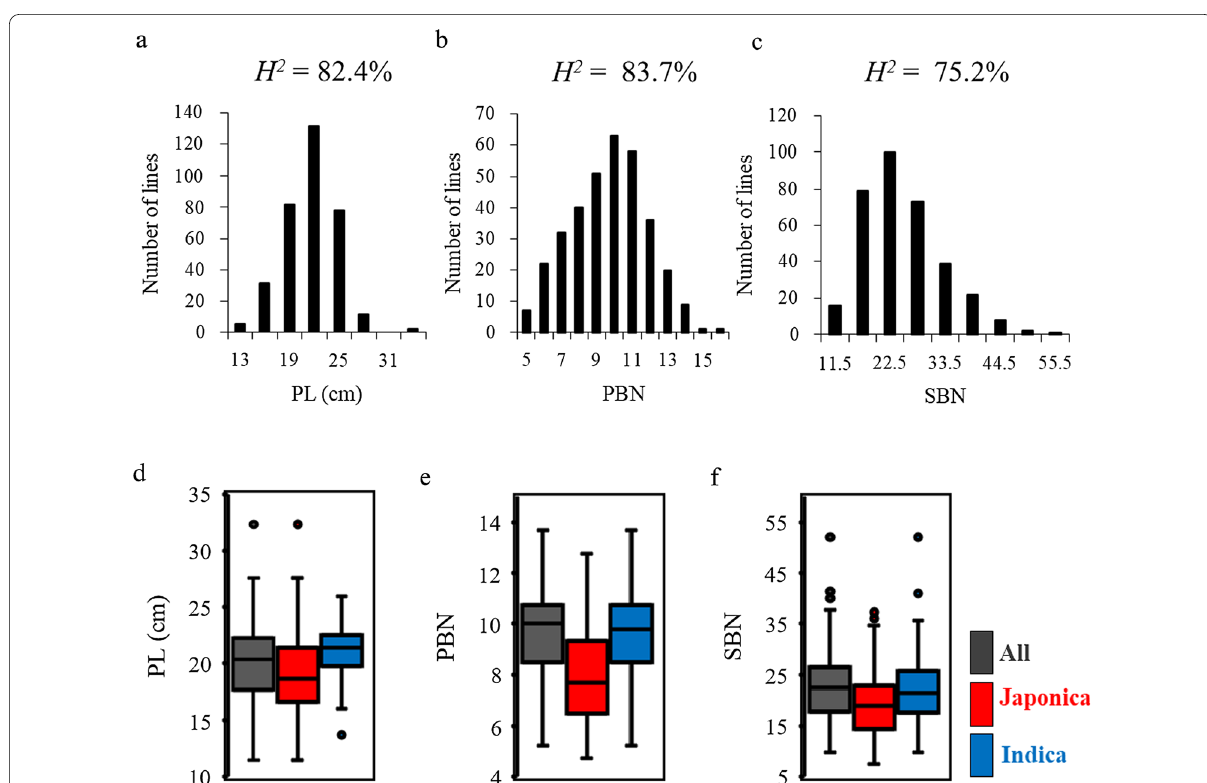
Fig. 1 Panicle architecture traits of the three rice panels in 2017. a – c Distributions of a panicle length (PL), b primary branch number (PBN), and c secondary branch number (SBN) of the whole panel. H 2 , broad-sense heritability. d – f Box plot of the phenotypic variation of d PL, e PBN, and f SBN within the whole panel, and indica and japonica sub-panels. Boxes show median, and upper and lower quartiles. Whiskers extend to 1.5 interquartile range, with any remaining points indicated with